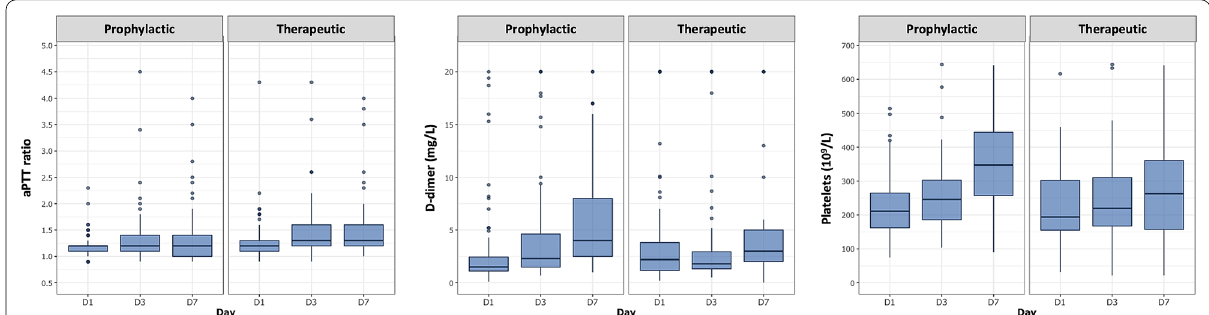
Fig. 3 Kinetics of coagulation parameters in therapeutic and prophylactic groups at days 1, 3 and 7 after ICU